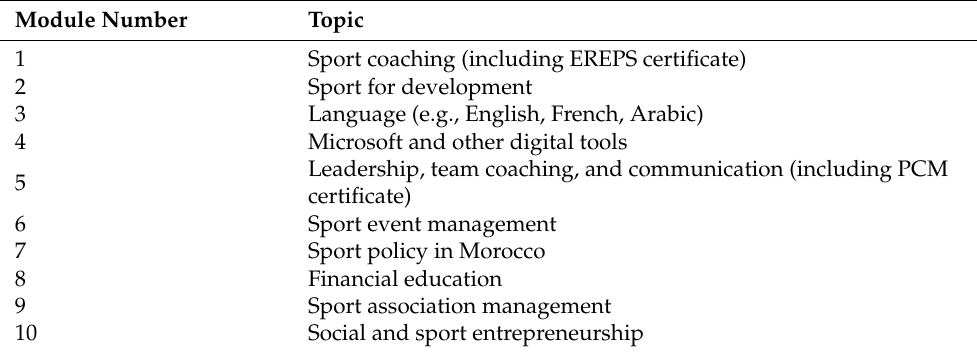
Table 2. Overview of SAME modules. Adapted from